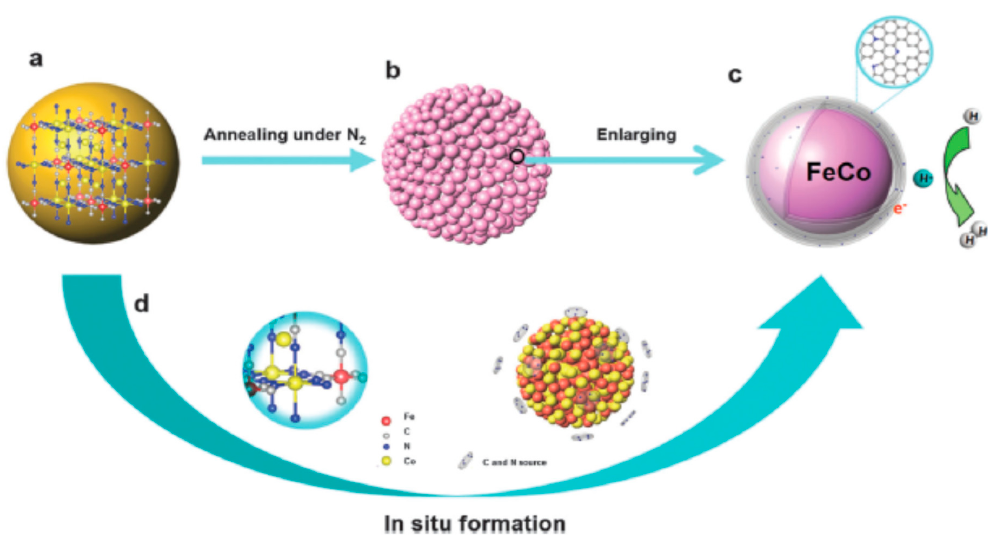
Figure 5. The illustration of synthetic process and model of the FeCo alloys decorated on nitrogen doped graphene layers by annealing corresponding metal–organic frameworks (MOFs), reproduced with permission from [43]. Copyright Royal Society of Chemistry, 2015.